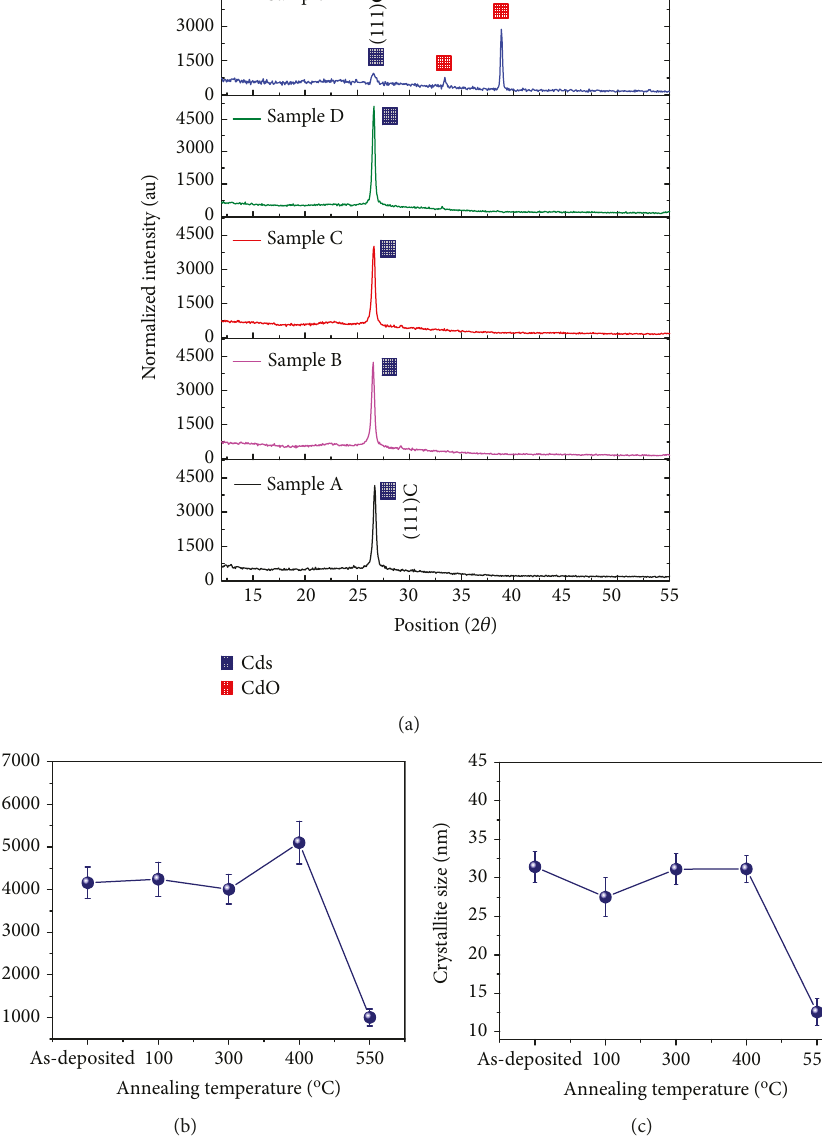
Figure 3: X-ray di ff raction analysis of CdS thin fi lms. (a) XRD spectra of the as-deposited and annealed CdS fi lms. (b) Variation of the maximum intensity of the (111) peak as a function of the annealing temperature. (c) Variation of the grain size with the annealing